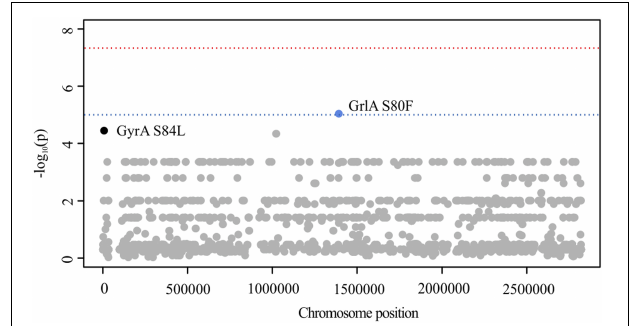
FIGURE 4 | Manhattan plot illustrating CPT PLINK results. The -log 10 GC-corrected p- values of identified SNPs are plotted against the chromosome position of S. aureus 04-02981. The blue line indicates suggestive association ( p = 1 × 10 − 5 ), while the red line indicates genome-wide significance threshold ( p = 5 × 10 − 8